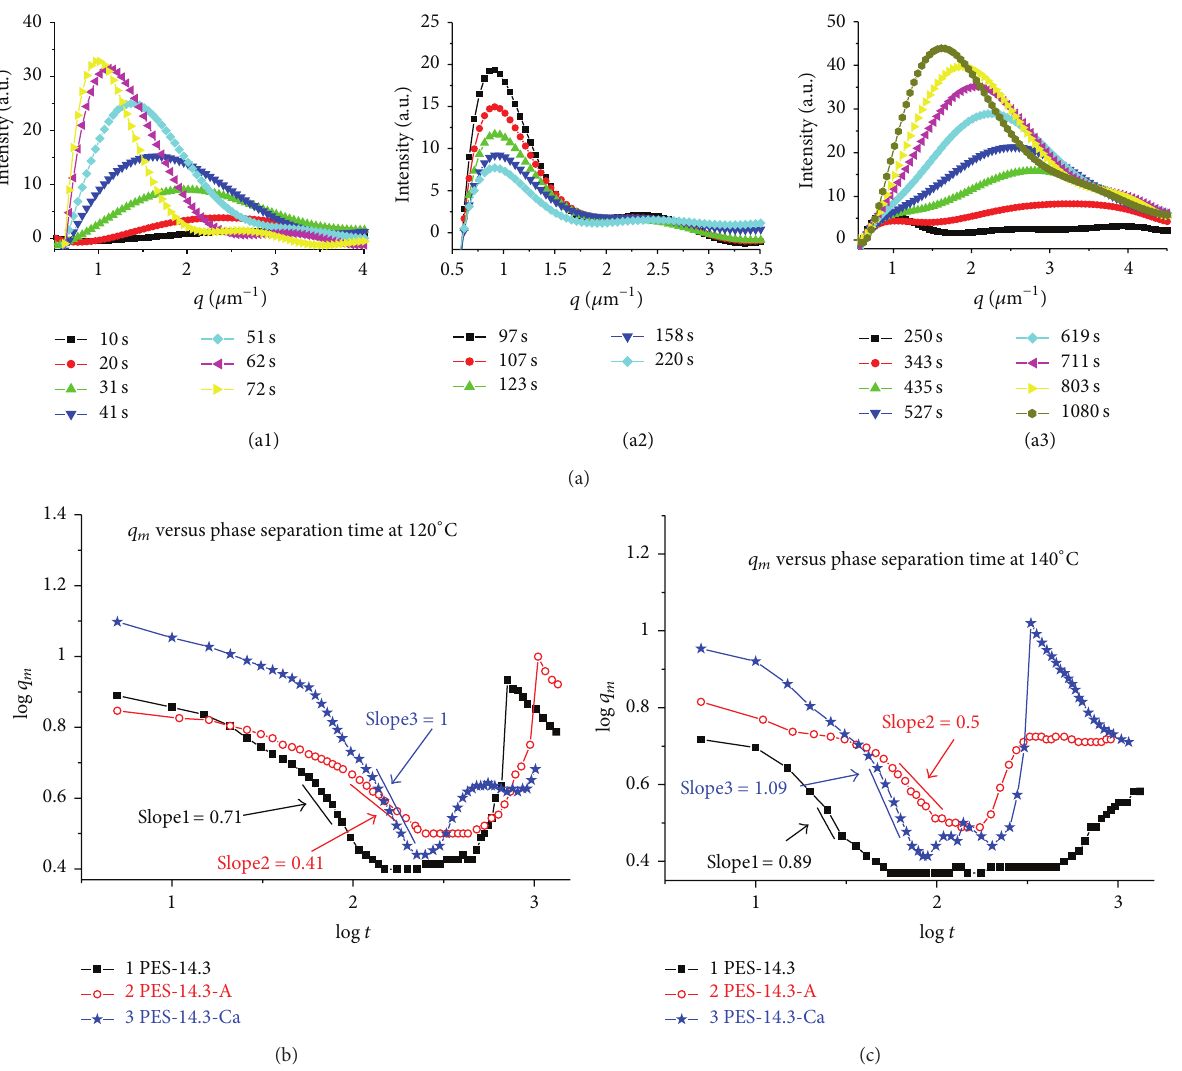
Figure 4: The changes of scattering vector, 𝑞 𝑚 , and light intensity versus time of the PES-14.3 blends with and without fillers. (a) PES-14.3-Ca cured at 140 ∘ C, (b) 𝑞 𝑚 versus time at 120 ∘ C, and (c) 𝑞 𝑚 versus time at 140 ∘